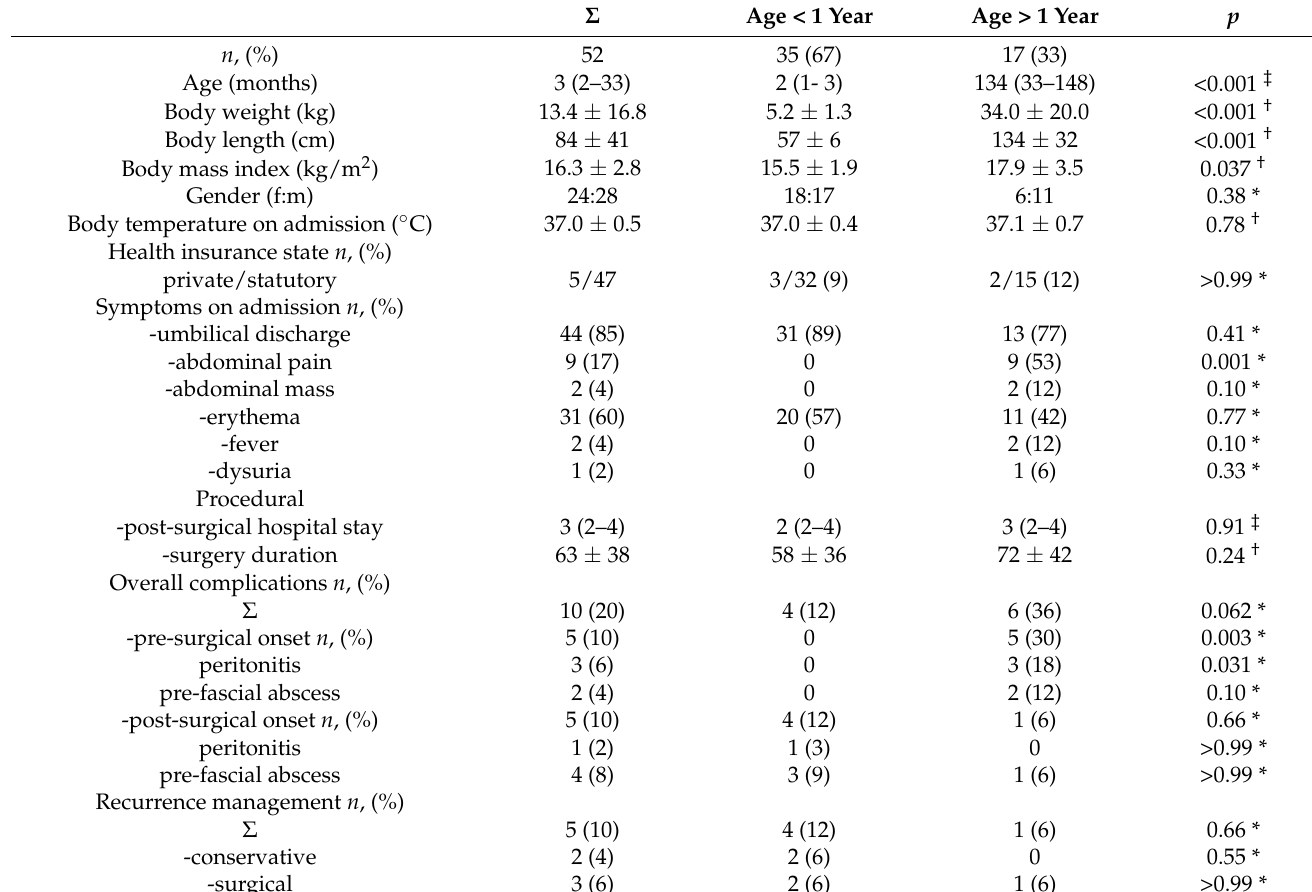
Table 1. Age dependent characteristics of urachal